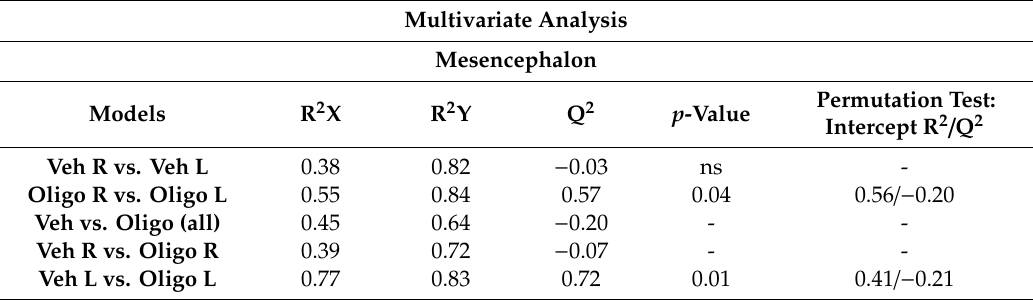
Figure 2. Score plot of the supervised models of R and L mesencephalon. The scores of the samples represent the result of the association / covariance between the Y-variables (treated or not-treated with oligomers rats) and metabolites concentrations as predictors (X-variables). ( A ) Partial least square discriminant analysis (PLS-DA) models comparing the R and L mesencephalon from Vehicle (respectively black and dark grey circles) or Oligo (respectively white and light grey diamonds) classes; ( B ) PLS-DA models comparing the mesencephalon of the Vehicle class (black circles) and Oligo class (white diamonds). Table 1. Summary of the statistical parameters of the supervised models of the mesencephalon analysis.